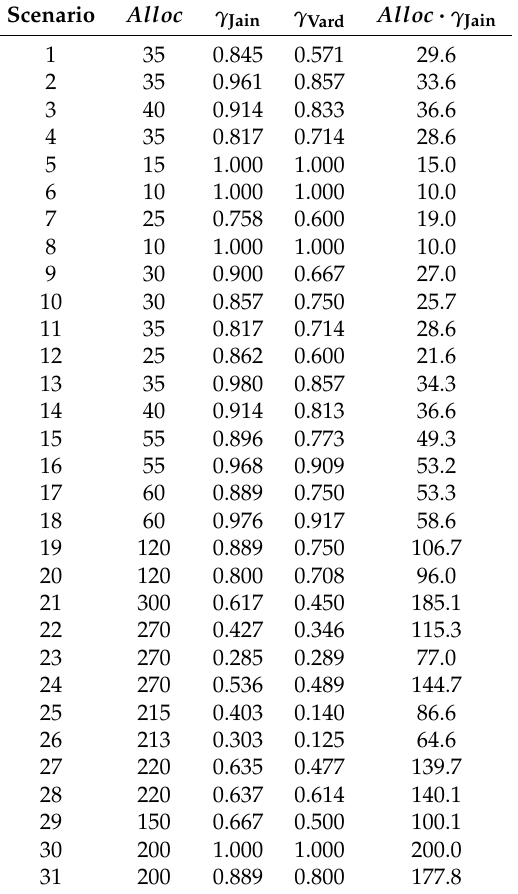
Table 12. Performance evaluation for BFF-I. Alloc values in